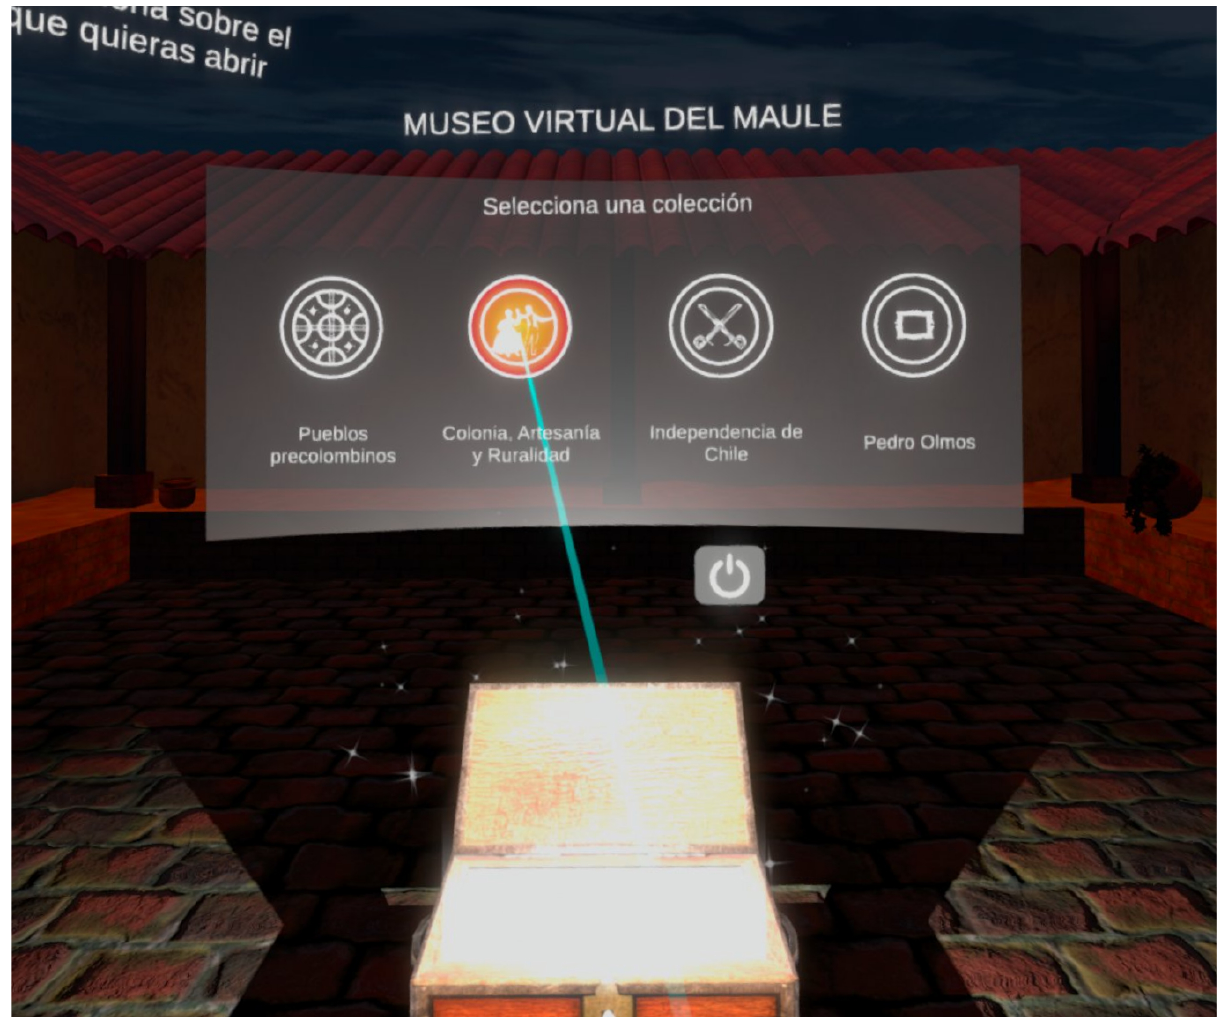
Figure 1. Graphical user interface of the virtual museum: the front panel where the user can access the 3D pieces through the available collections. The main GUI has three panels: front (in the image), left, and